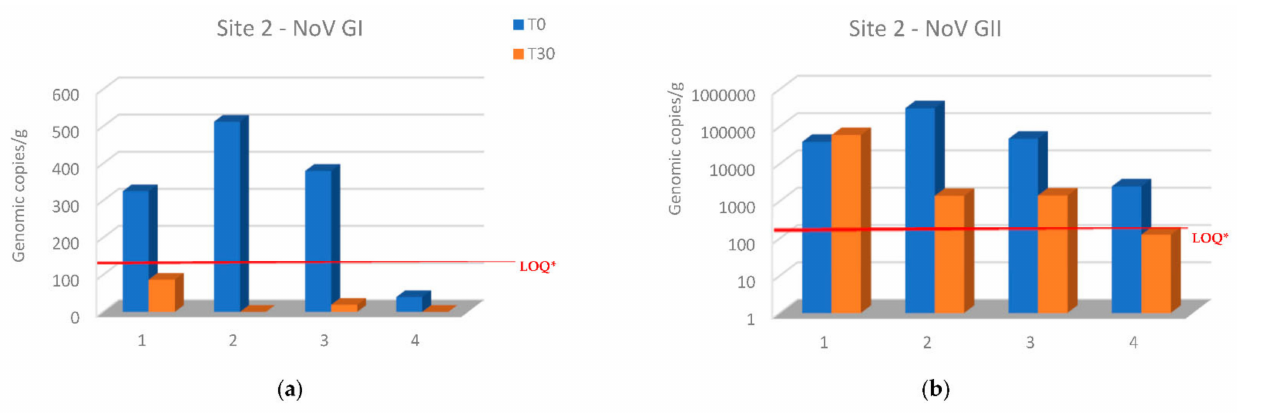
Figure 3. Comparison of NoV RNA levels in oysters at Time 0 of the relay (T0) and after 30 days of the relay (T30) at site 2: ( a ) NoV GI; ( b ) NoV GII. Values are expressed in genome copies/gram. * LOQ: 140 g.c./g for NoV GI and 130 g.c./g for NoV GII. Both NoV GI and NoV GII levels decreased in all oyster samples of site 1 when